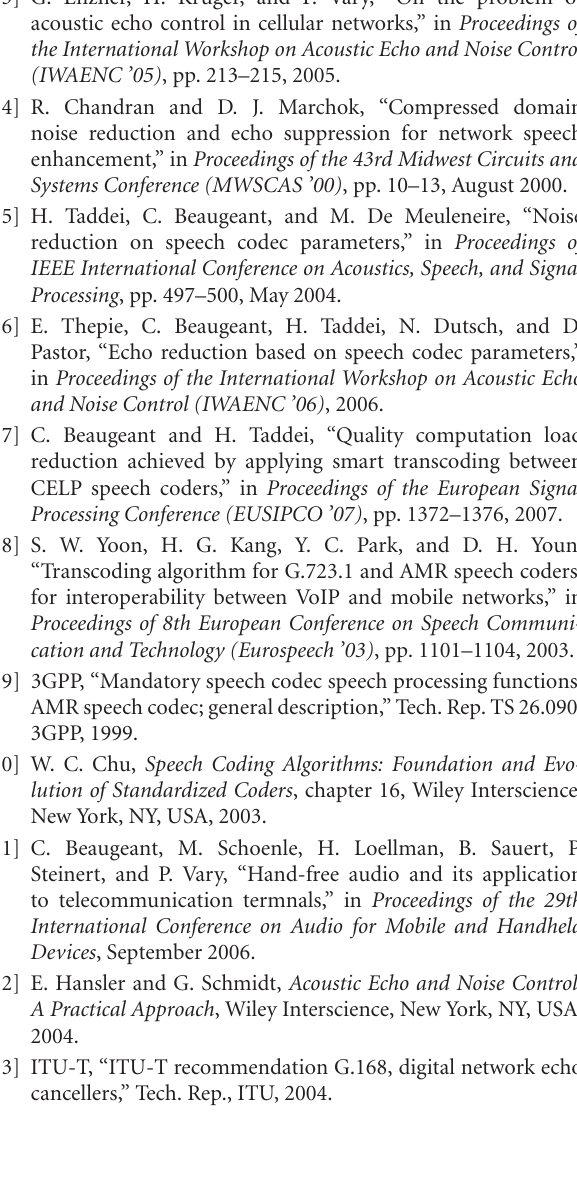
Table 1: Overall Echo Return Loss